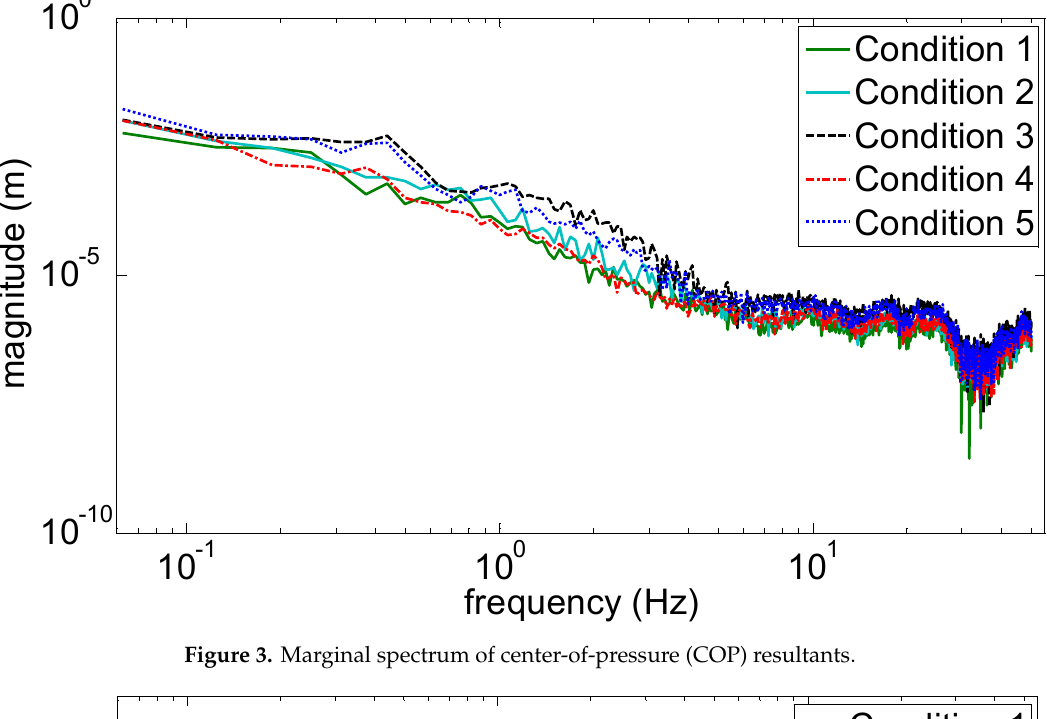
Figure 3. Marginal spectrum of center-of-pressure (COP) resultants.